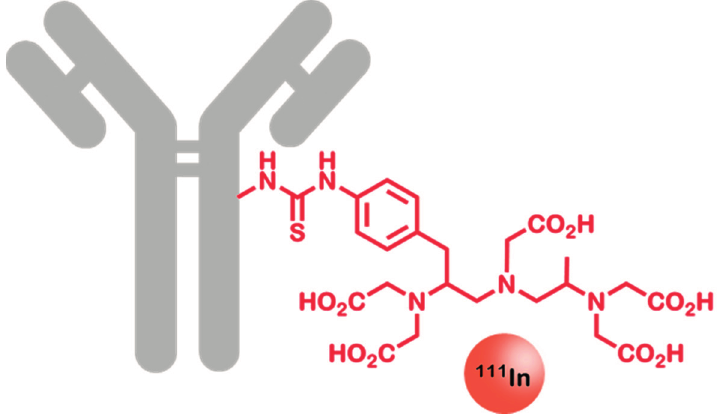
Figure 7. 111 In-ibritumomab-tiuxetan (Zevalin ® ). The monoclonal antibody ibritumomab (grey) is highly specific for CD20, which is overexpressed by many different lymphomas. The chelator tiuxetan (red) is able to bind 111 In, as well as 90 Y. This allows molecular imaging and the subsequent therapy of CD20 positive lymphomas. For reasons of clarity, chelation bonds are